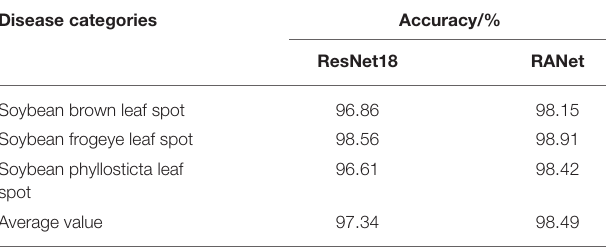
TABLE 3 | Accuracy of various disease test